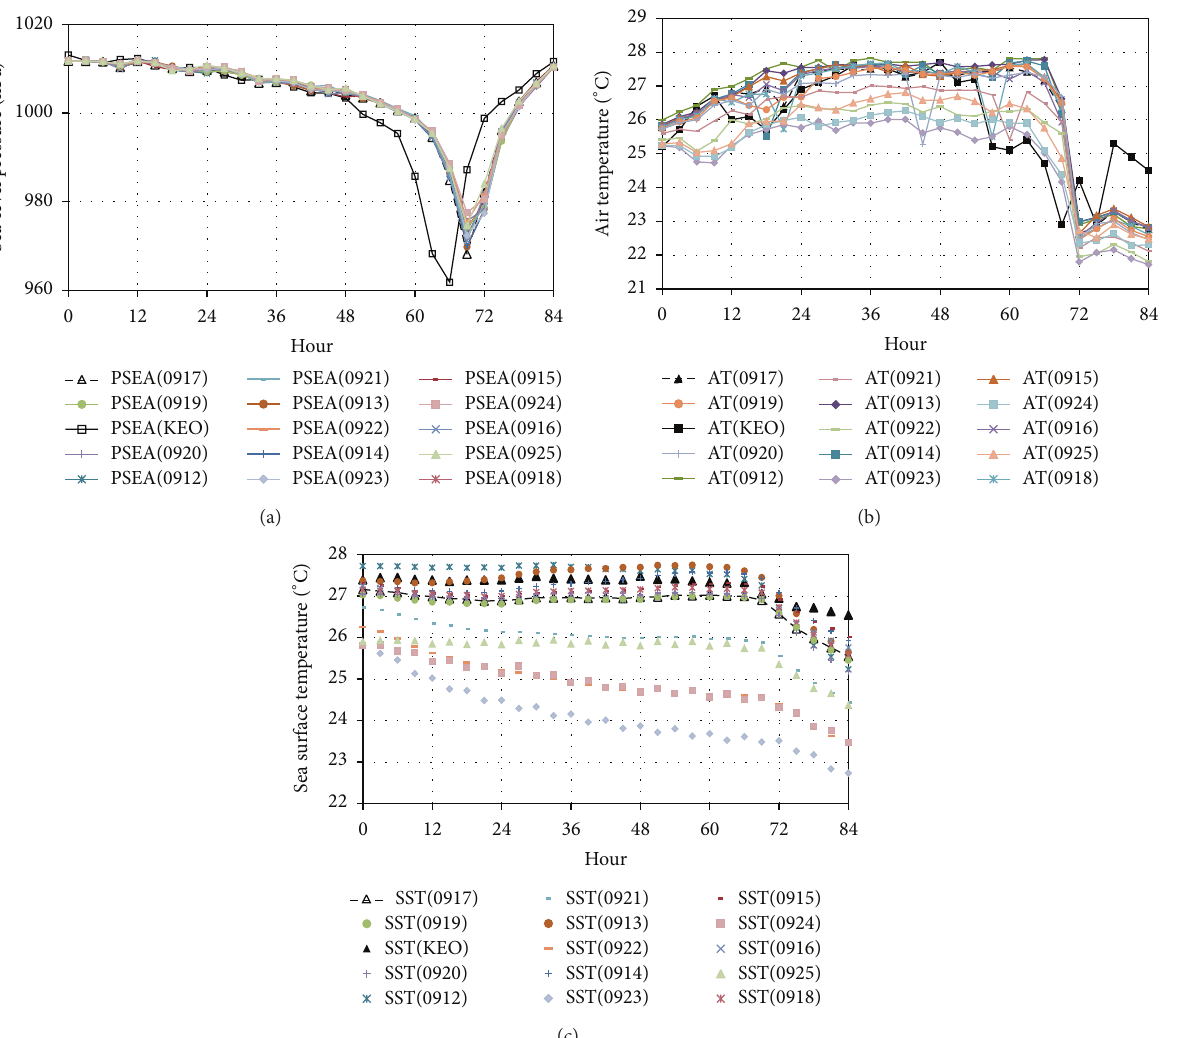
Figure 13: Time series of (a) observed and simulated sea level pressure in all experiments, (b) observed air temperature at 10m height and simulated air temperature at 20 m height in all experiments, and (c) observed and simulated sea surface temperature in all experiments at 32.4 ∘ N, 144.5 ∘ E, the location of the KEO moored